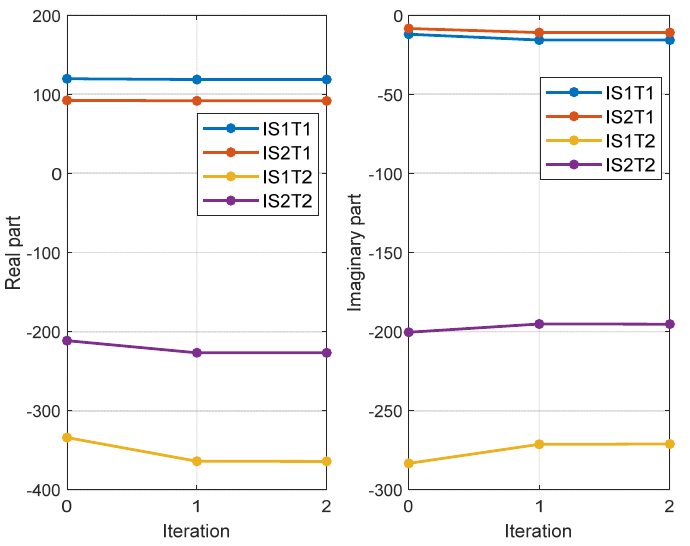
Figure 5. Secondary-side current values for each iteration. The voltage E 12 is defined as the origin of Figure 5. Secondary - side current values for each iteration. The voltage 𝐸 (cid:2869)(cid:2870) is defined as the origin the vectors in the complex reference of the vectors in the complex reference frame.